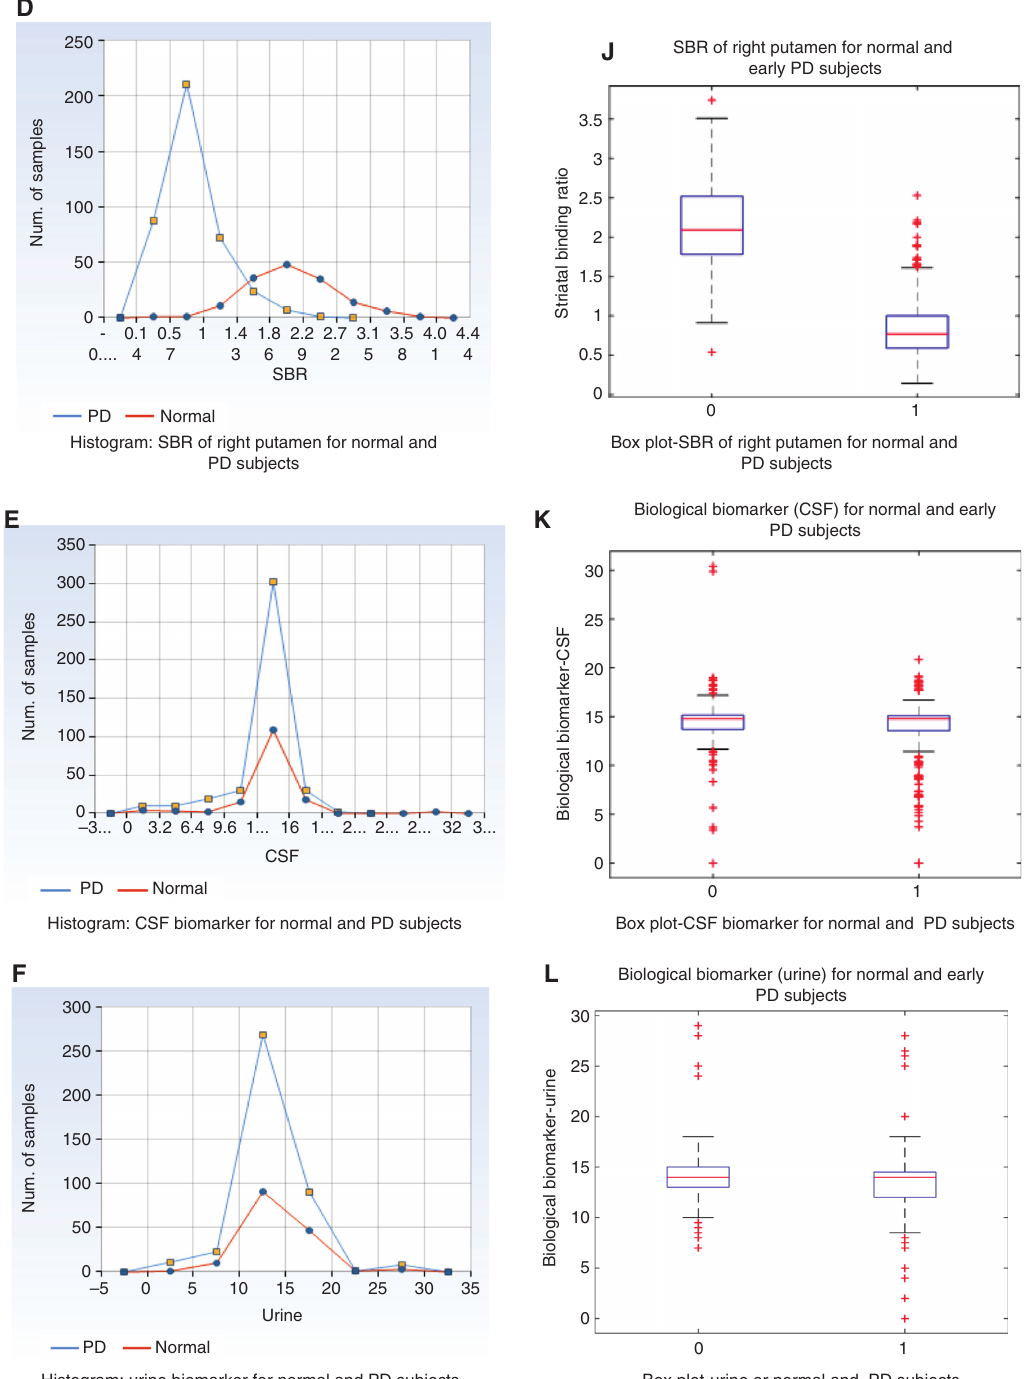
Box plot-urine or normal and PD